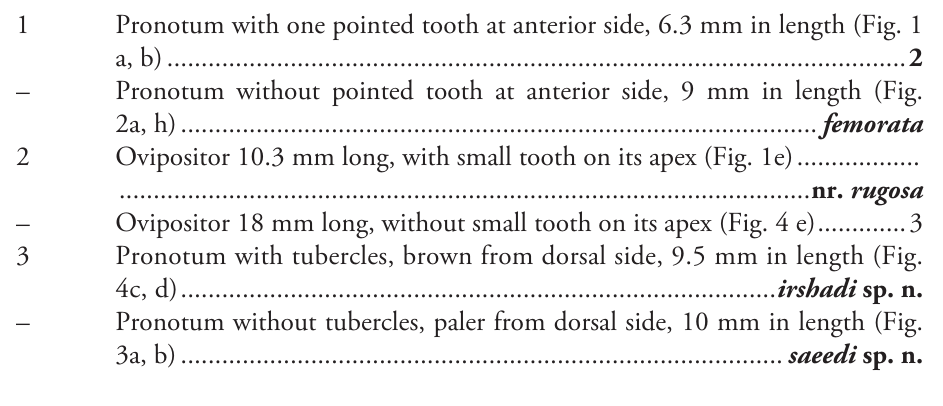
Diagnostic features. Dark brown tegmina with distinct dots (Fig. 1a, b , c). Prono- tum has one pointed tooth on anterior side and several on posterior end; in the centre two transverse sulci are located just behind the middle (Fig. 1a–d). Centre of fore,